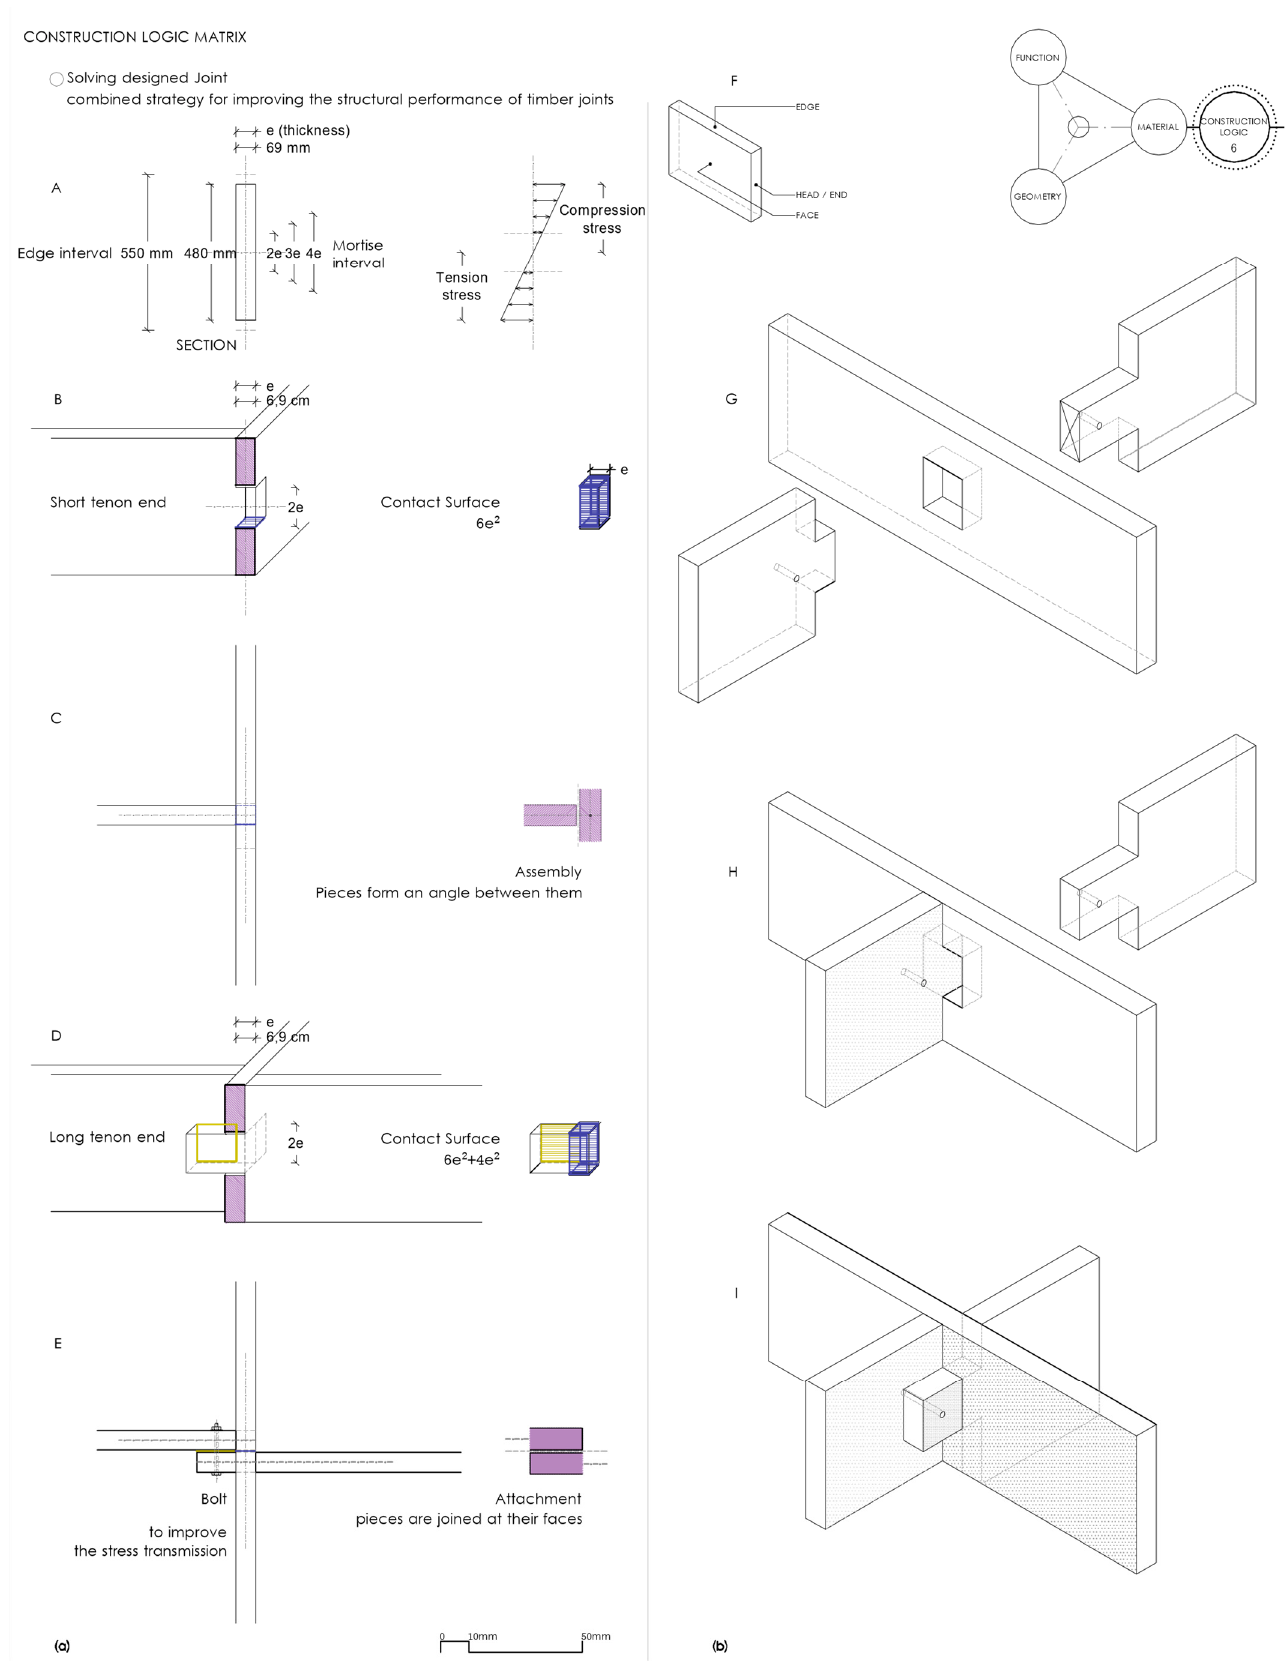
Figure 17. Construction logic matrix 6.